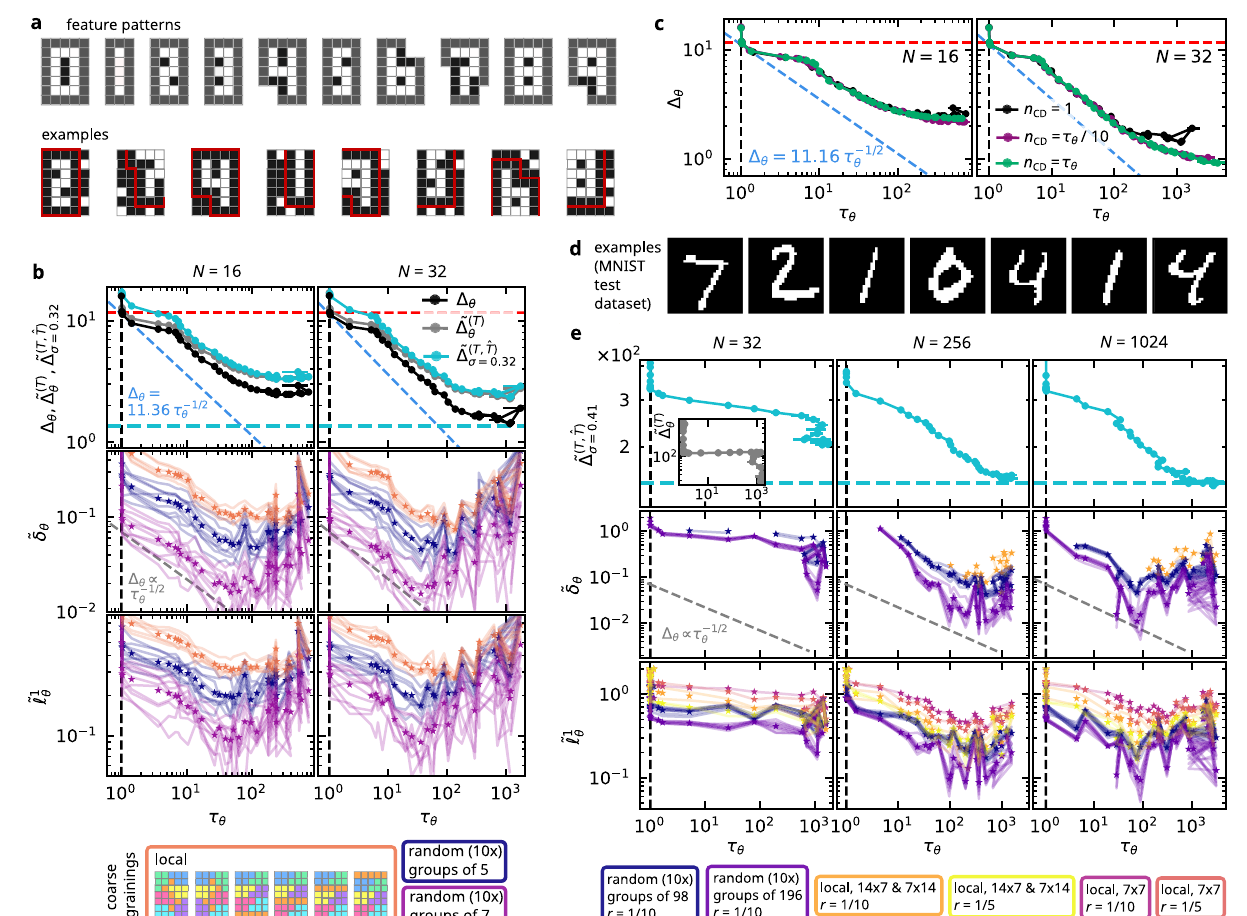
Fig. 4 | Approximate RBM learning characteristics on digit images. a Images of error ~ δ θ using majority-rule ( r =1) coarse-grainings of samples from the target and modeldistributions, partitioning pixels intolocalor randomgroups(seemain text M =5×7pixelsshowingpatternsof thedigits0through9(selecteduniformly)ata random location. Gray pixels must either be made black ( x i =0) or be cut away by fordetails).Solidlines:resultsforindividualpartitions;starmarkers:averageofthe the image boundaries (see examples in the second row). Pixels that are not part of solidlinesofthesamepartitioningtype(color,seelegend).Bottom:empiricalerror ~ ‘ 1 Δ θ vs. τ θ for N =16(left)and N =32(right)hidden the pattern are active (white) with probability q =0.1. The total number of such θ forthesamecoarse-grainings. c images is 40,507,353. b Variouslossmeasuresvs.autocorrelationtime τ θ for N =16 units, utilizing persistent contrastive divergence (PCD) with fi xed ( n CD =1) or (left) and N =32 (right) hidden units, utilizing persistent contrastive divergence adaptive ( n CD ∝ τ θ ) approximation order; other hyperparameters as in b . d Examples from the MNISTdataset, which comprises images of M =28×28 pixels (PCD) with n CD =1, η =0.005, B =100 on ∣ S ∣ =50,000 training images. Top: Exact showing handwritten digits. e Similar to b , but for the MNIST dataset and PCD loss Δ θ (black),exacttesterror ~ Δ ð T Þ θ (empiricallossforatestdataset T of ∣ T ∣ =10,000 ^ T Þ ∣ ^ T ∣ =10 6 , training with n CD =1, η =10 − 4 , B =100, ∣ S ∣ =60,000, ∣ T ∣ =10,000, ∣ ^ T ∣ =10 6 , σ =0.41, images, gray), and Gaussian-smoothened empirical loss estimate ~ Δ ð T , σ ( σ =0.32, cyan). The cyan dashed line marks ~ Δ ð T , S Þ : 354, the minimal Gaussian- and ~ Δ ð T , S Þ σ =0 : 41 =147 : 4.Missingdatapointscorrespondto ~ δ θ = 1 and/orunrealiable τ θ σ =0 : 32 =1 smoothenedlossestimatebetweenthetestandtrainingdatasets.Middle:empirical